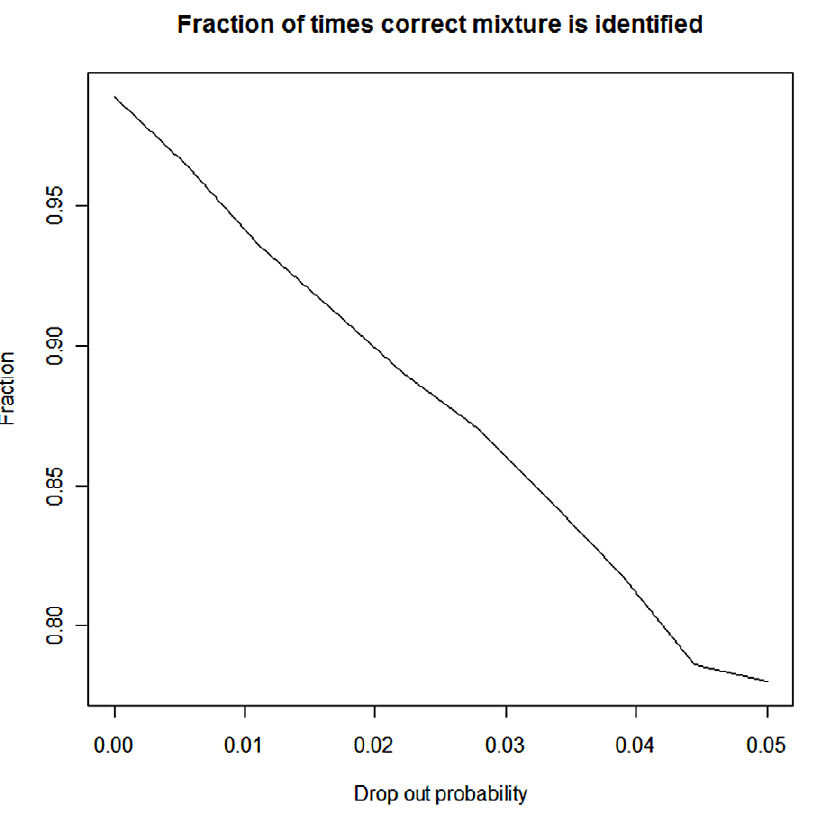
Figure 3. The fraction of times the correct model is identified becomes lower as the drop out probability increases, but it stays above 80% as long as the drop out probability is below